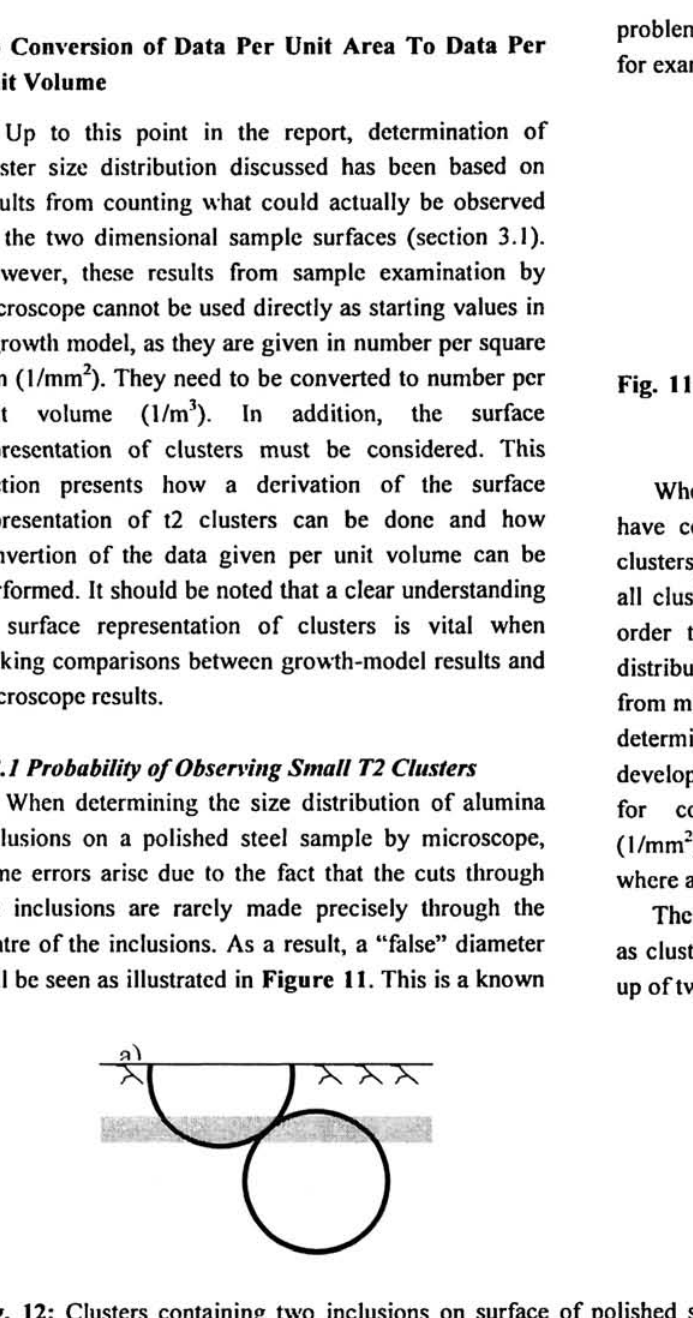
Fig. 12: Clusters containing two inclusions on surface of polished steel sample. Note that sample surface must be ground down to grey area (a) for the t2 cluster to be